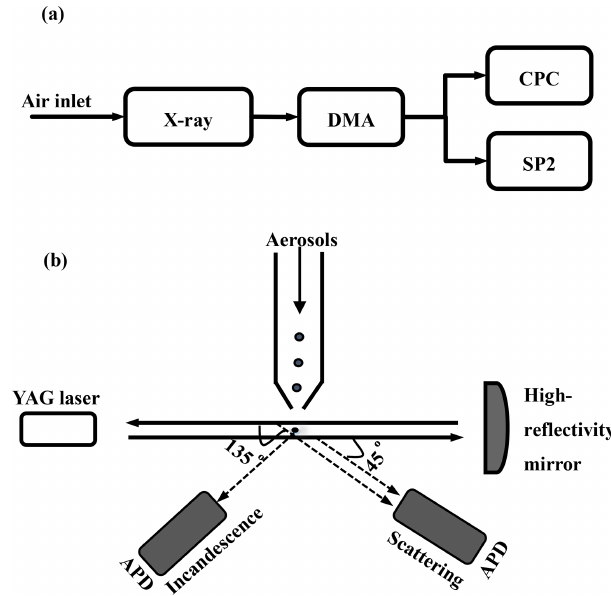
Figure 1. (a) Schematic of the measurement system. (b) Diagram of SP2